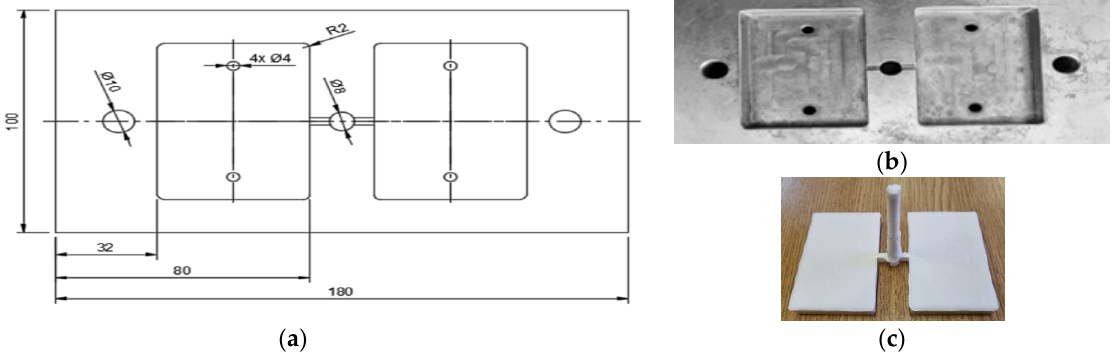
Figure 1. The active plate of the mold: ( a ) the dimensions of the active plate and the forming cavities; ( b ) the real image of the active plate; ( c ) parts obtained by injection molding.